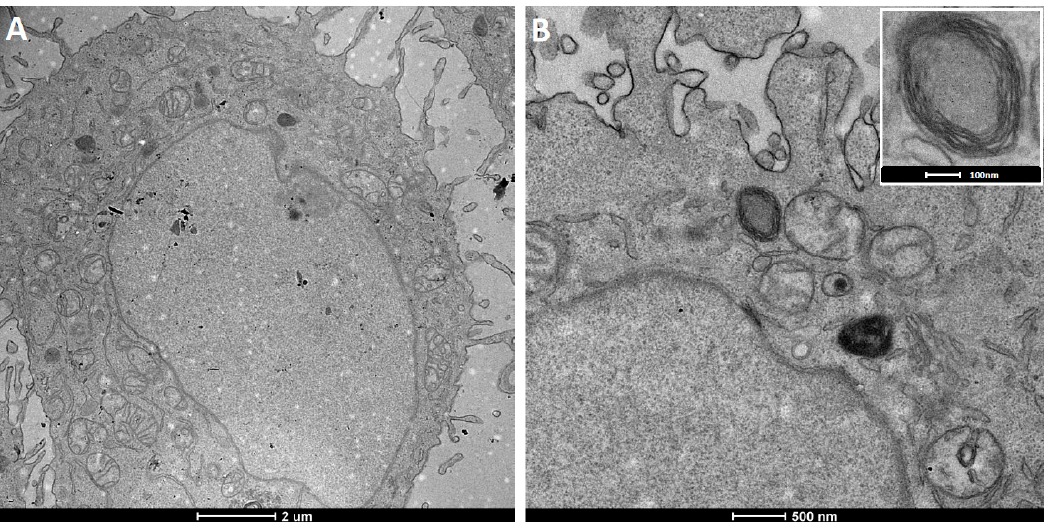
Figure 5. TEM ultrathin sections of HeLa cells after 12 h incubation with fluorescent magnetopolymersomes (PBD(1200)- b -PEO(600), 10% SPION, 5% DEAC). ( A ) Overview of a typical preparation showing few polymersomes as dark spherical objects and ( B ) peripheral cell region with a rare observation of an internalized magnetopolymersome. The inset depicts a close-up of a multilamellar magnetopolymersome judged from contrast and membrane thickness.